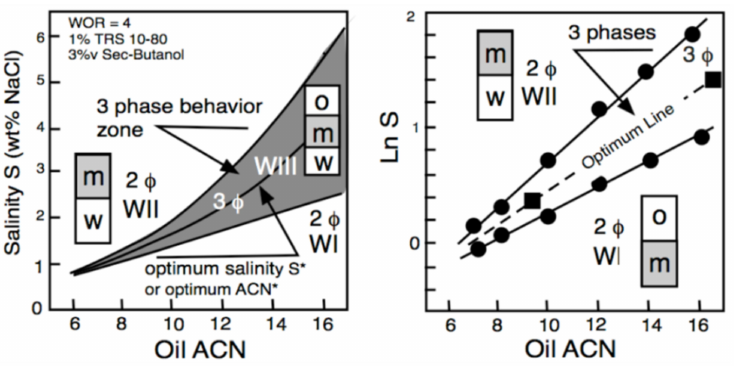
Figure 4. Bidimensional (water salinity and oil ACN) formulation scan [5]. S* is the salinity at optimum